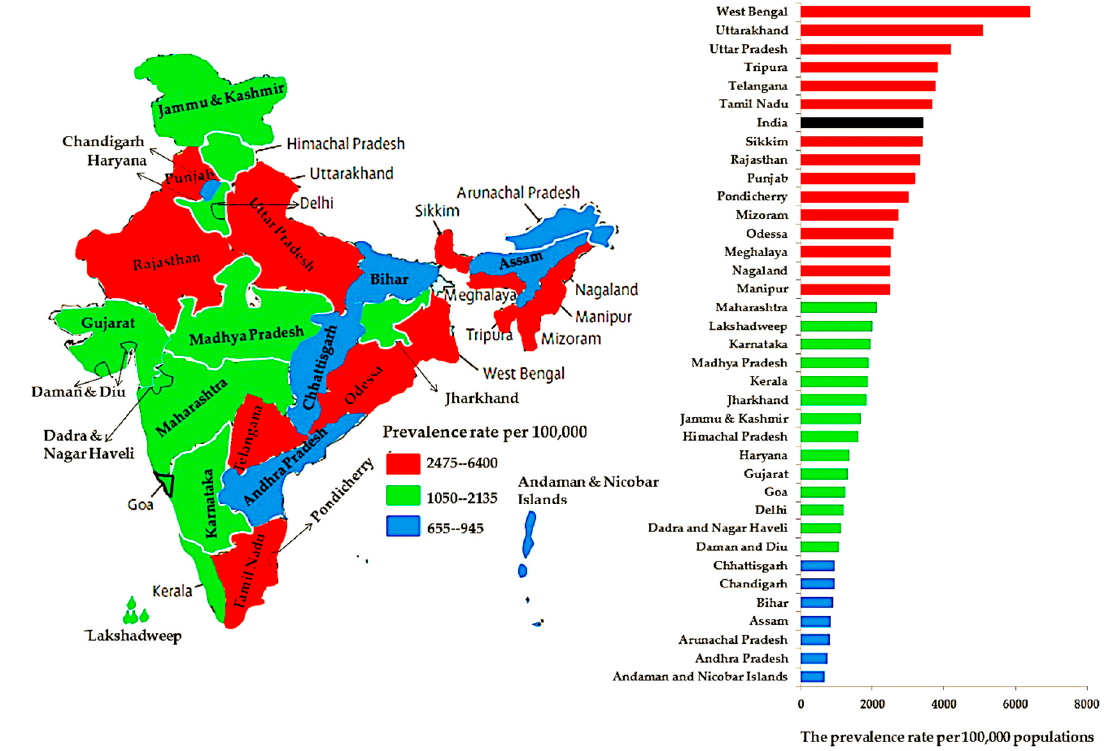
Figure 3. The prevalence rates of overweight among adults at the national level and per state and union territory.